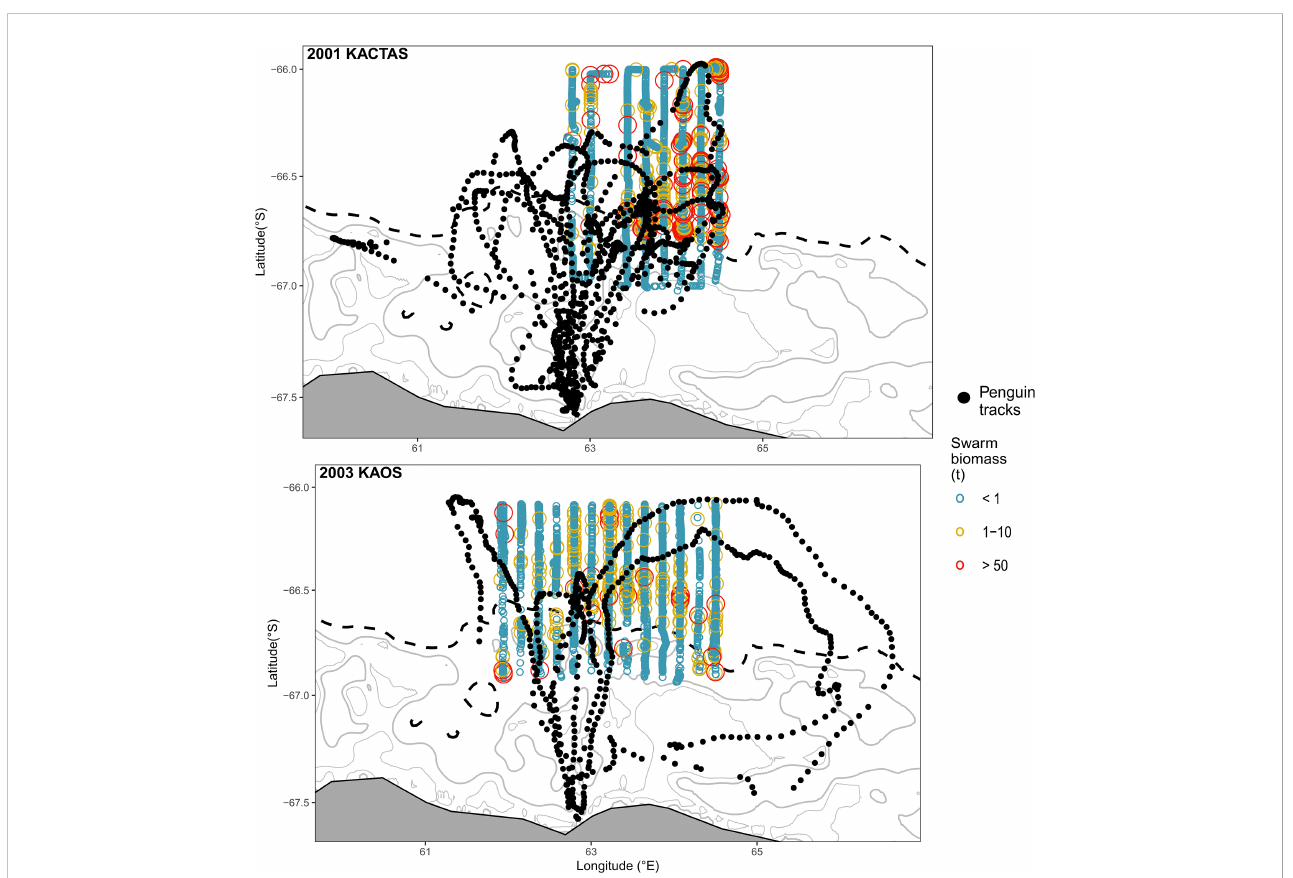
FIGURE 1 Distribution of krill swarm biomass in the waters off Be ́ chervaise Island collected during KACTAS and KAOS. To aid visual presentation, krill swarms are grouped in discrete biomass categories. Swarms within transects are overlaid with SSM- fi ltered location estimates for chick-rearing Ade ́ lie penguins (n = 18 individuals on n = 19 foraging trips). Major land features are in grey and major bathymetric features (shelf break and other bathymetric features > 1000m) are illustrated by black dashed lines. Bathymetric contours are displayed at 100m intervals. Inset panel in (A) shows the study region (red circle) in East